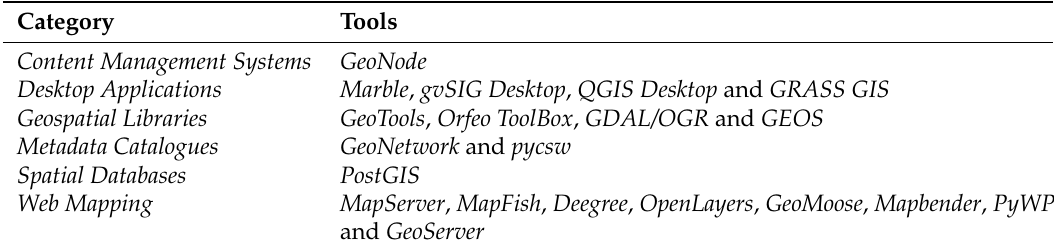
Table 1. List of the selected OSGeo tools considered in our